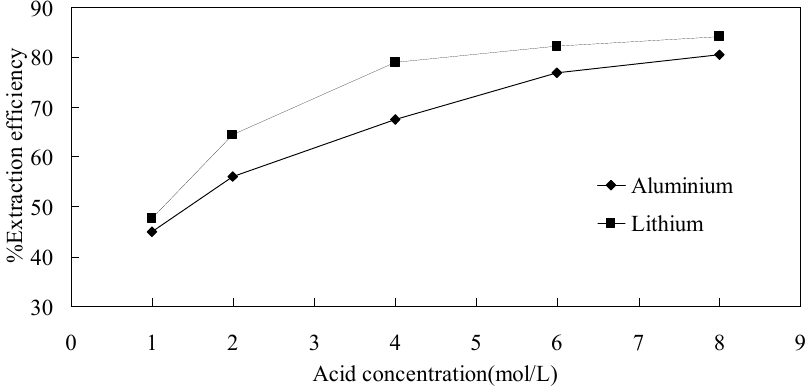
°C , S/L ratio of 1/20, 4 h).